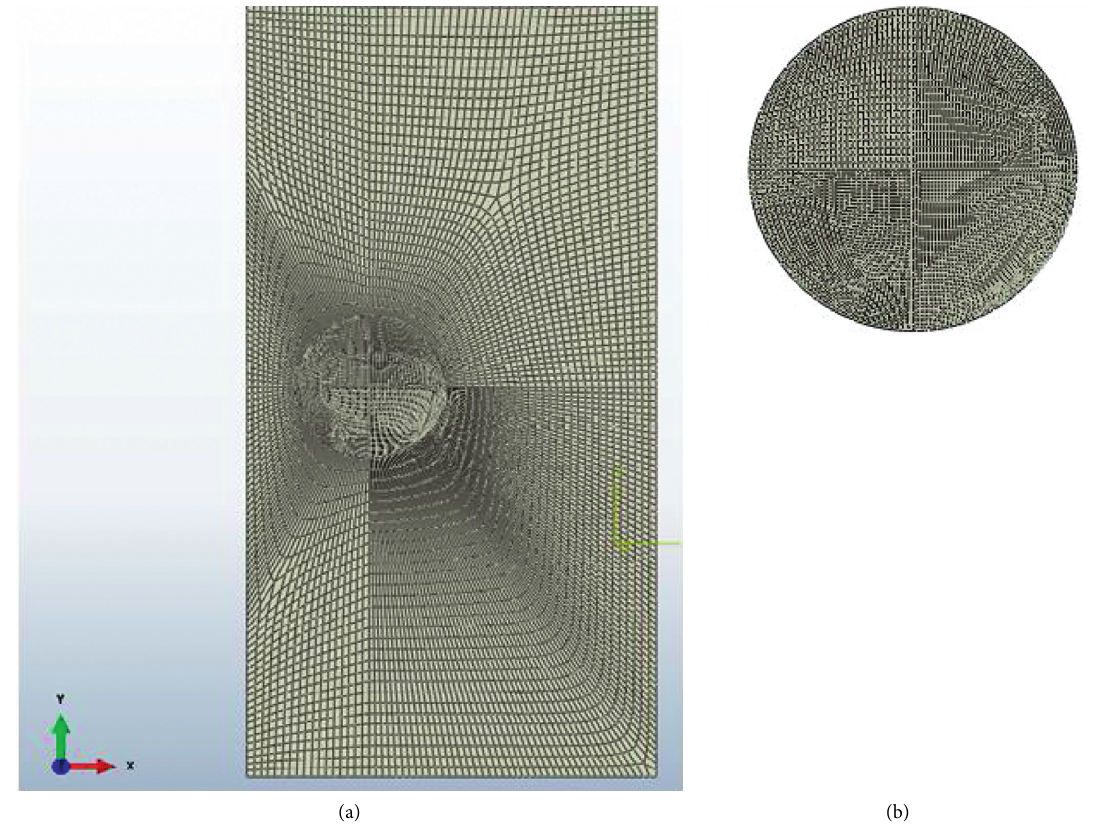
Figure 5: (a) Global mesh and (b) local mesh.